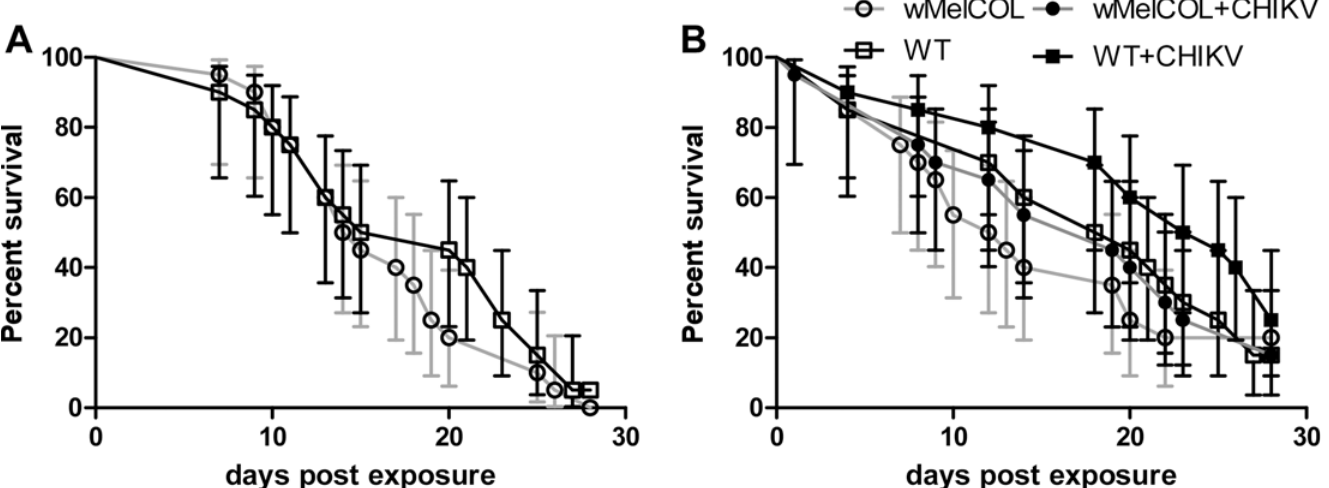
Fig 4. Survival curves of WT (black line) and w MelCOL mosquitoes (gray line) orally infected with 6.90 (A) or 9.00 (B) log 10 PFU/ml of CHIKV. Error bars represent 95% confidence